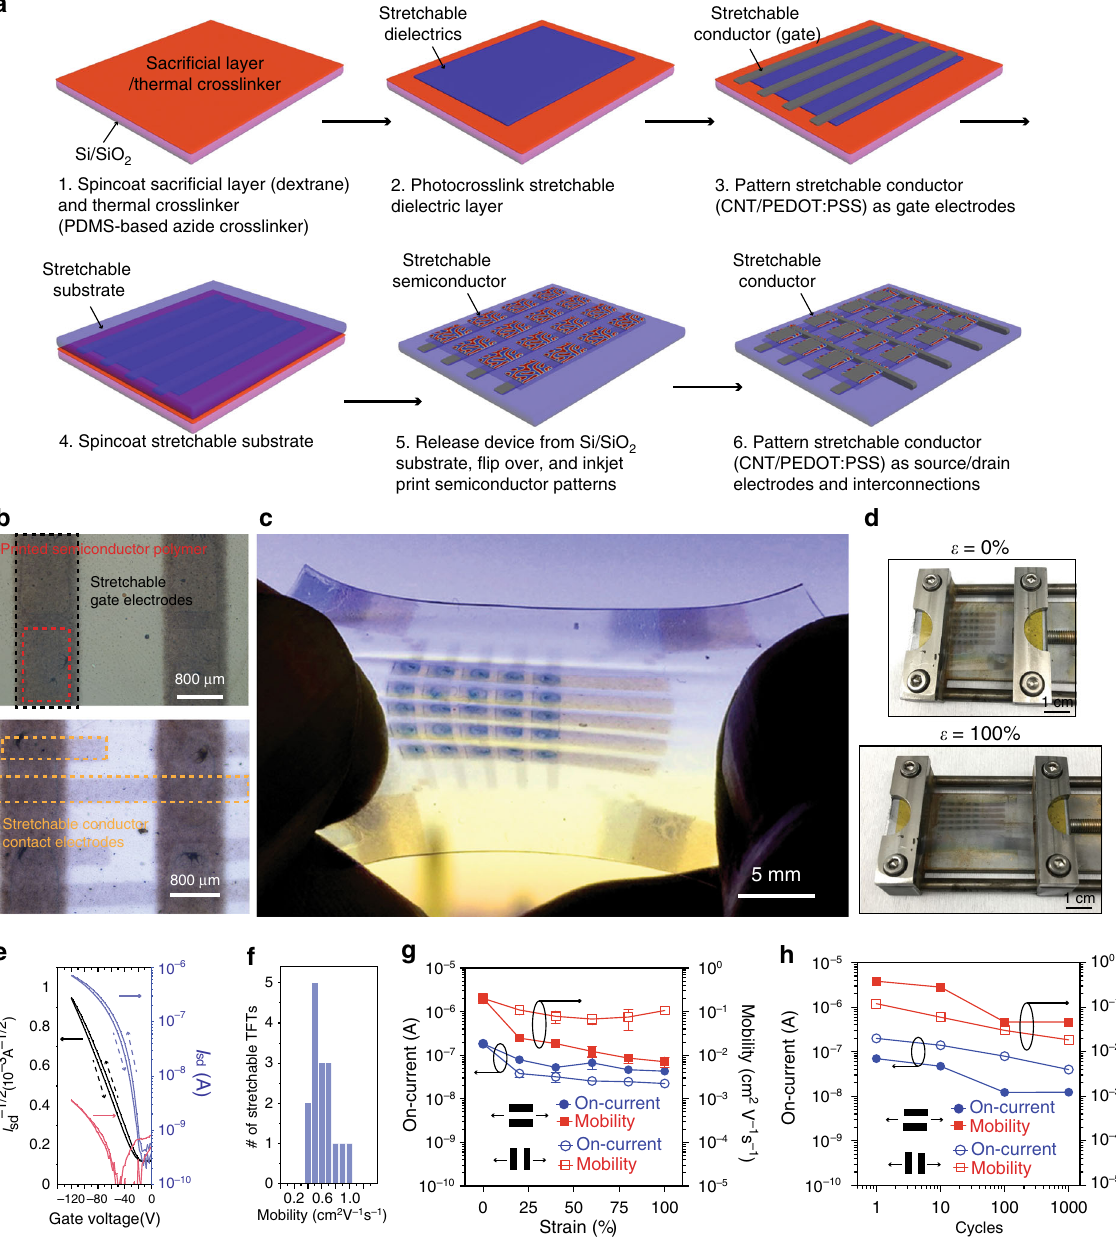
Fig. 3 Fully stretchable OTFT array. a Fabrication process. A water-soluble sacri fi cial layer was spin-coated on a Si/SiO 2 wafer followed by a PDMS-azide layer. A chemically orthogonal stretchable dielectric layer (PFPE-DMA) is spin-coated and UV cured. A stretchable conductor as the gate electrode is spray-coated through a shadow mask fi rst with a mixture of CNT/poly(3,4-ethylenedioxythiophene) fl owed by a PEDOT:PSS layer. Then a stretchable substrate made of PDMS is spin-coated. After curing, the entire structure is soaked in water and is released from the substrate and fl ipped over. Inkjet printing is used to pattern the stretchable semiconductor on the stretchable dielectric layer. Stretchable electrodes made of CNT/PEDOT:PSS are spray- coated through a shadow mask to give the source/drain (S/D) electrodes. b Optical microscopic images of a printed stretchable semiconductor pattern (red dashed box) on the PFPE-DMA dielectric fi lm with stretchable CNT gate electrodes (black dashed box)and a fully stretchable transistors array with top CNT/PEDOT:PSS stretchable S/D contact electrodes (yellow dashed boxes) on the patterned semiconductors. c An optical photographic image of a fully stretchable 5 × 5 transistor active-matrix array. d Optical photographic images show the stretchable transistor array being subjected to 0% and 100% strain. e A representative transfer curve ( V d = − 100 V) of the stretchable OTFT at 0% strain. f Distribution of the mobility from 16 devices on the fully stretchable OTFT array (Supplementary Fig. 8). g Changes in the saturation on-current and saturation mobility at gate voltage of − 100 V and drain source voltage of − 100 V with strains up to 100%, both parallel to (open circles) and perpendicular to ( fi lled circles) the charge transport direction ( n = 3). Values are mean ± S.D. h Changes in the saturation on-current and saturation mobility measured at gate voltage of − 100 V and drain source voltage of − 100 V after multiple stretching-releasing cycles (up to 1000 cycles) at 100% strain parallel to (open circles) and perpendicular to ( fi lled circles) the charge transport